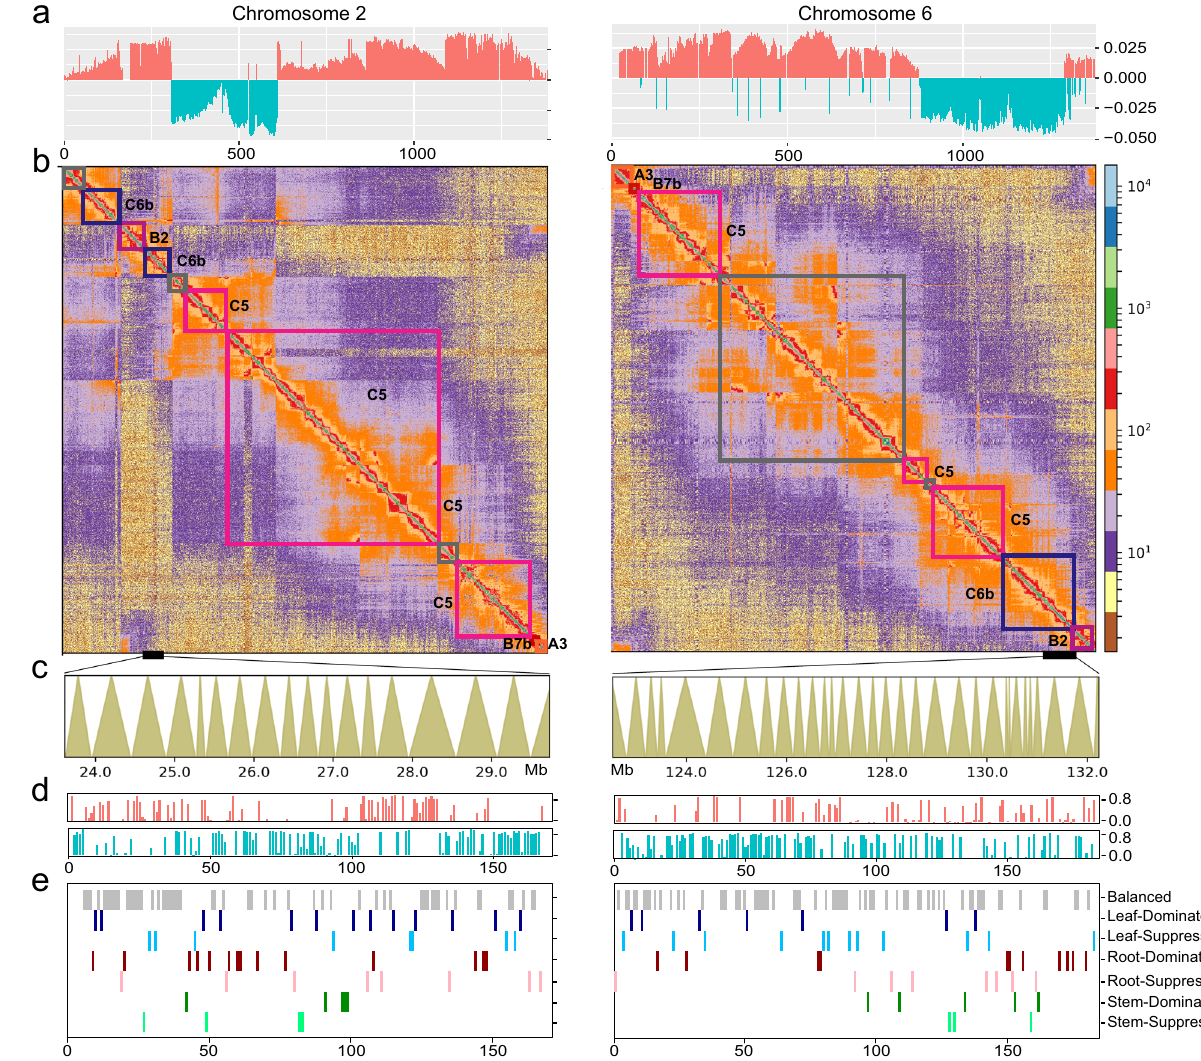
Fig. 3 Three-dimensional (3-D) genome architecture, cytosine methylation and gene expression patterns in extant Panax stipuleanatus genome. a Activated A (red) and inactivated B (blue) compartments at 100 Kb resolution on extant Panax chromosomes 2 and 6. The two chromosomes were duplicated through the Pg- β duplication event. X - and Y -axis are the numbers of 100 Kb sliding bins and PCA eigenvectors of A/B compartments, respectively. Coordinates from left to right on chromosome 2 mirrored those on chromosome 6. b Heatmap of the chromatin interaction map at 100 Kb resolution. The color scheme on the right indicates the levels of chromatin interaction between the 100 Kb sliding bins. Colored boxes within the heatmap represent the ancestral core-eudicot chromosomes. Colors and names of these ancestral core-eudicot chromosomes are the same as in Fig. 1. The gray color box represents the homologous genomic region that was lost in extant grape genome. c Distribution pattern of topological association domain-like (TAD-like) structures on the post- γ segment C6b. The C6b segment on extant chromosomes 2 and 6 were duplicated by Pg- β . The x -axis indicates the physical position on extant P. stipuleanatus chromosomes. Each triangular shape represents a TAD-like structure. d Cytosine methylation of the duplicated ancestral core-eudicot genes on the two homologous segments C6b derived from Pg- β . Red and blue lines are, respectively, singletons and retained duplicates in the two segments C6b. X - and Y -axis denote the number of ancestral genes and methylation level, respectively. e Expression patterns of the duplicated ancestral core-eudicot genes in the two segments C6b. X -axis is the number of ancestral core-eudicot genes. Colors of these expressed genes indicate the seven expression patterns. Source data are provided as a Source Data fi